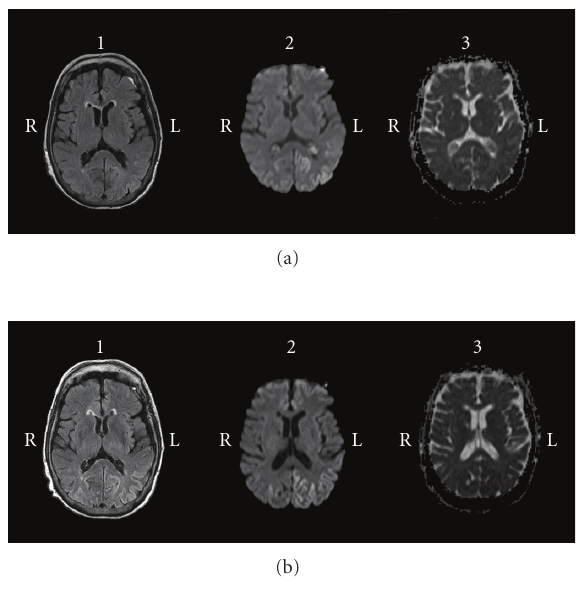
Figure 1: (a) Fluid attenuated inversion recovery (FLAIR), di ff u- sion weighted imaging (DWI) and apparent di ff usion coe ffi cient (ADC) MRI demonstrate bilateral temporal-occipital cortex pre- dominantly left hemispheric alterations with integrity of basal ganglia. (b) MRI images obtained two months later revealing the progression of the